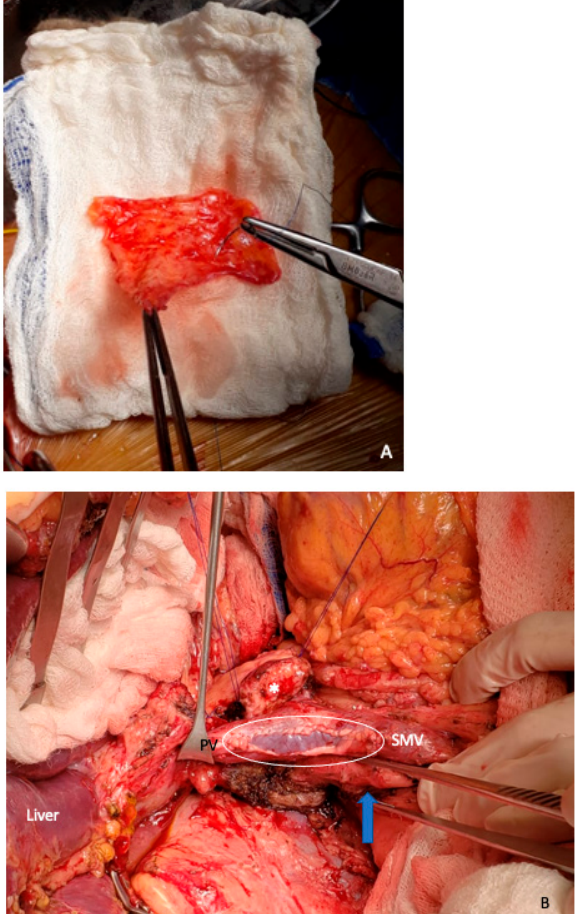
Figure 6. ( A ) Autologous parietal peritoneum was harvested from the right hypochondrium. ( B ) Type 2 vein reconstruction, using falciform ligament patch over the spleno–portal junction (white circle). The asterisk shows the distal pancreatic stump. The blue arrow shows the superior mesenteric artery. PV, portal vein. SMV, superior mesenteric